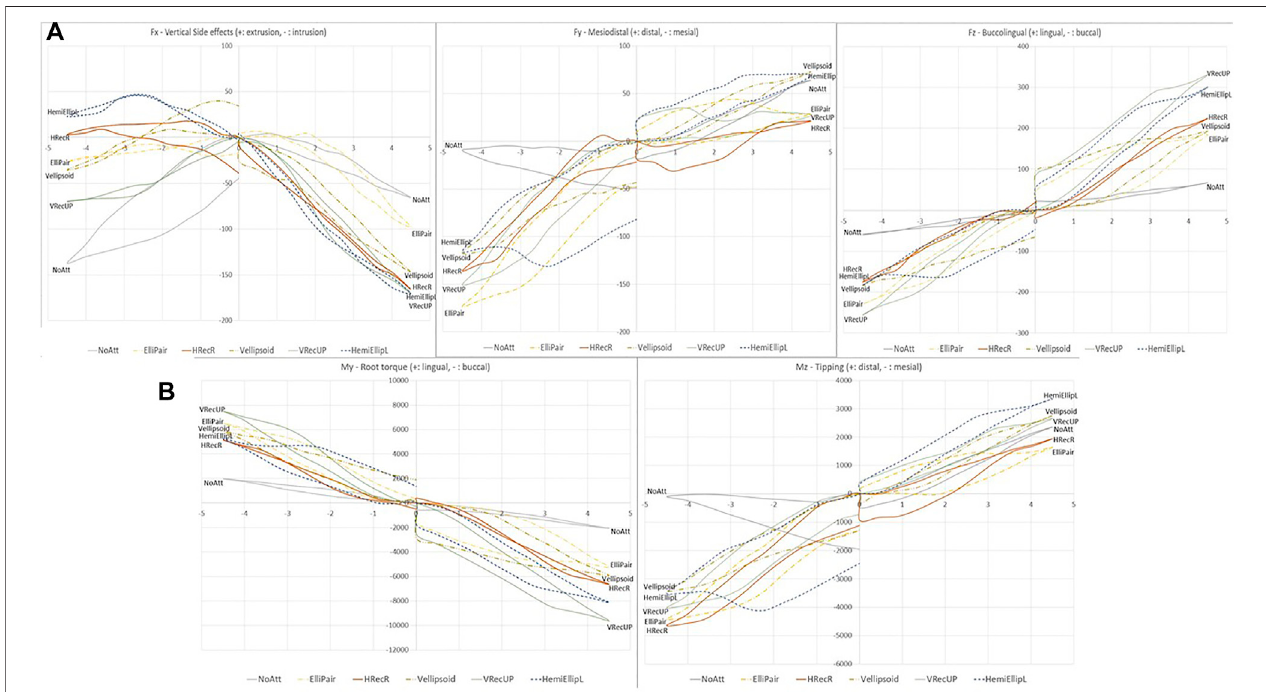
FIGURE 6 | Side effects observed in all three planes of space for the best performing attachments of each group in terms of (A) . Forces and (B) . Moments. Note that the NoAtt setup exhibits the least amount of side effects in most charts.